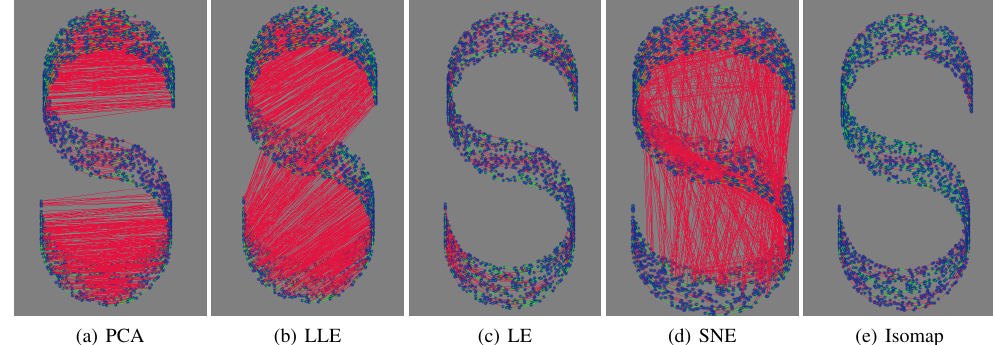
Figure 5: The MST of neighborhood graph of S-curve data points before and after dimension reduction. The green and red lines show the edges of trees before and after dimension reduction, respectively.